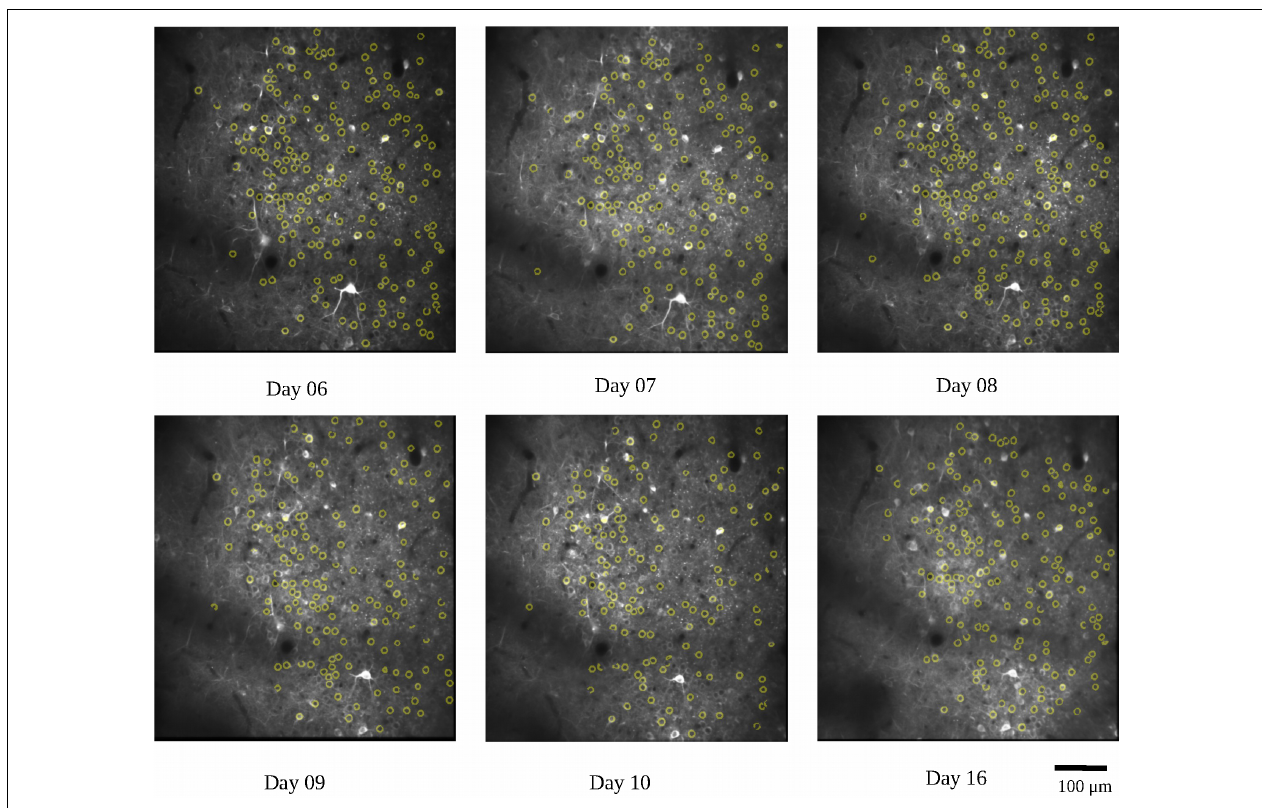
FIGURE 5 | Demonstration of the common neurons (yellow circles) detected in different recording days for mouse 9L. The detected common neurons were compared with neurons revealed in the average image of all recording days.